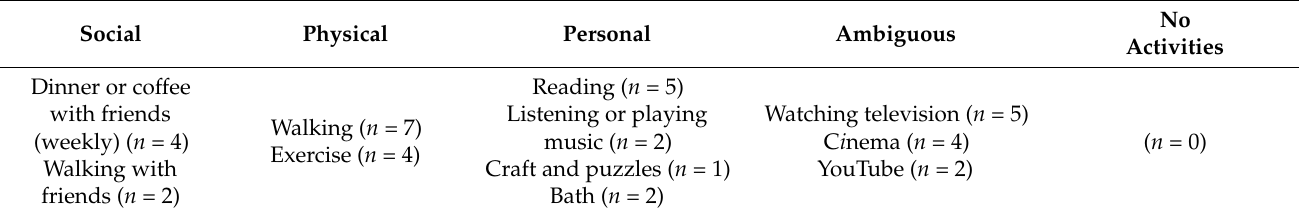
Table 1. Participant relaxation activities ( n =